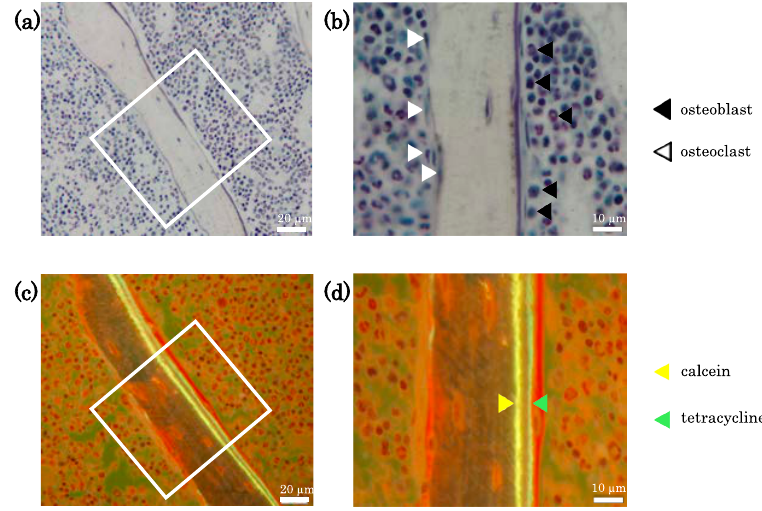
Figure 3 Villanueva Osteochrome Bone Stain of lumbar vertebrae Lumbar vertebrae stained with Villanueva Osteochrome Bone Stain. Images show sagittal cross-sections of lumbar vertebrae of osteoporotic model mice stained with Villanueva Osteochrome Bone Stain. (a) and (c) show low-power fields (scale bar=20 μ m). (b) and (d) show high-power fields (scale bar=10 μ m). (a) and (b) were observed under natural light. (c) and (d) were observed under fluorescent light. Black arrowhead=osteoblasts; white arrowhead=osteoclasts; green arrowhead=calcein; yellow